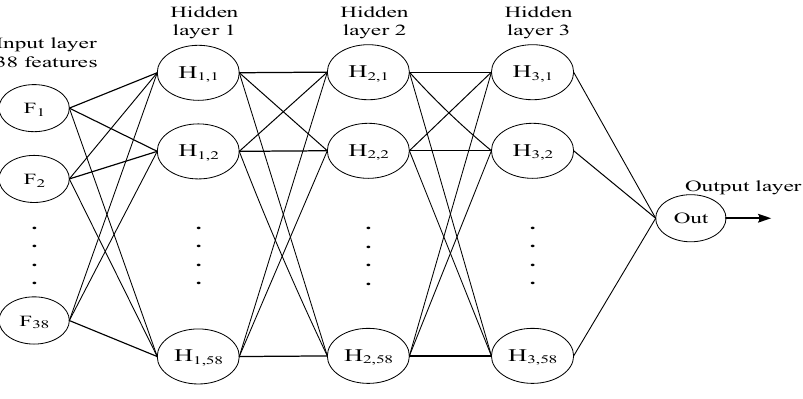
Figure 8. Architecture of deep neural network (DNN).